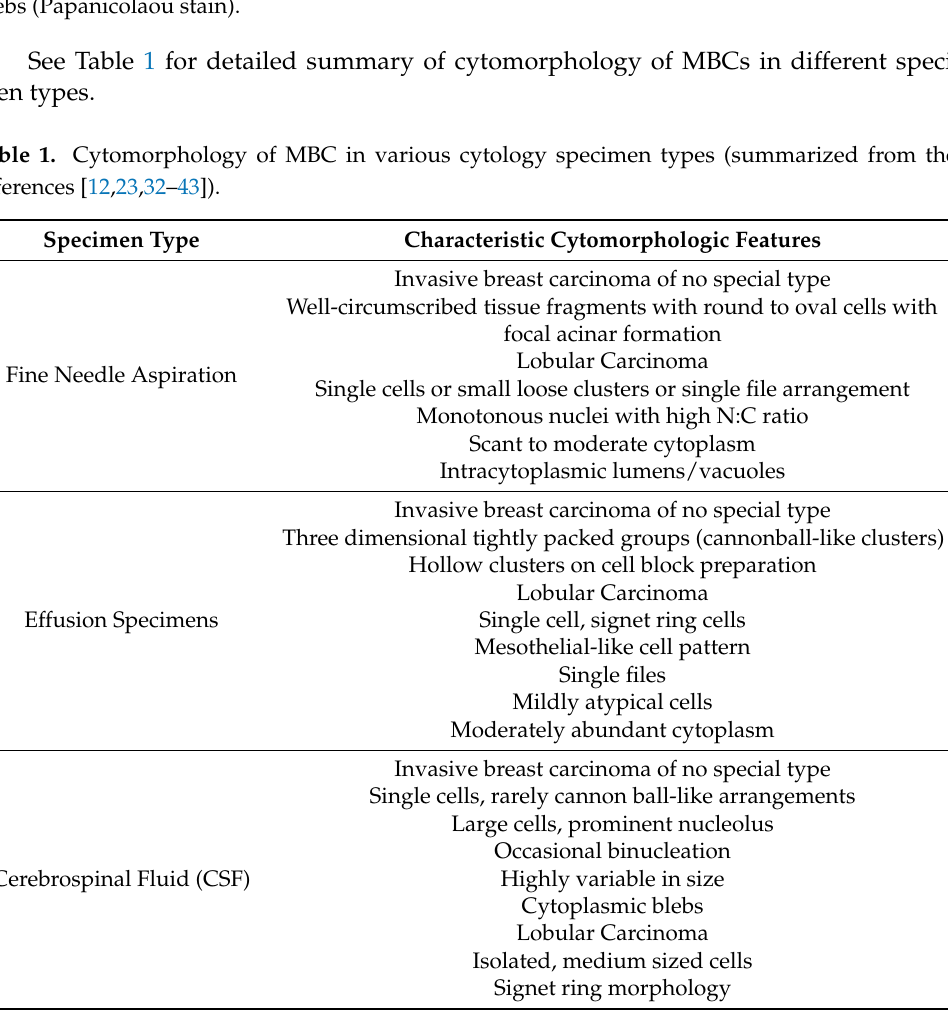
Figure 6. ( A , B ) Metastatic breast cancer in CSF. Malignant cells are large and variable in size. Nuclei are round to irregular with prominent nucleoli and moderately abundant cytoplasm with cytoplasmic blebs (Papanicolaou stain).